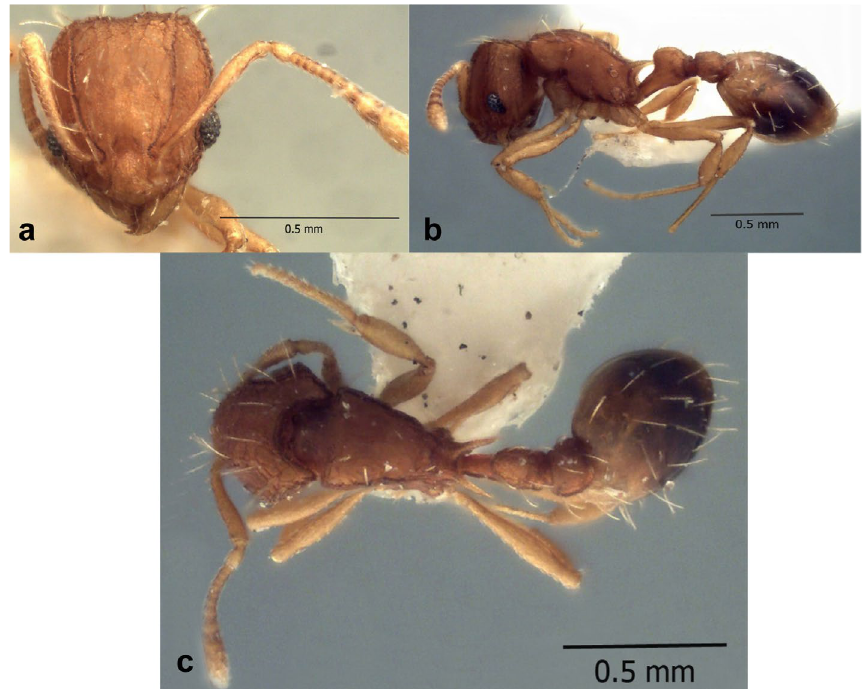
Figs 5a-c . Worker of Wasmannia longiseta n. sp. 5a, head in full-face view; 5b, profile; 5c, dorsal